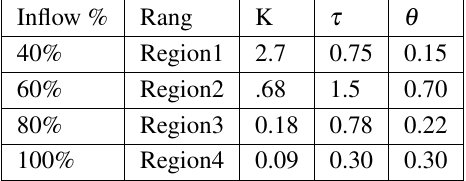
Table 2. Process parameter at different valve